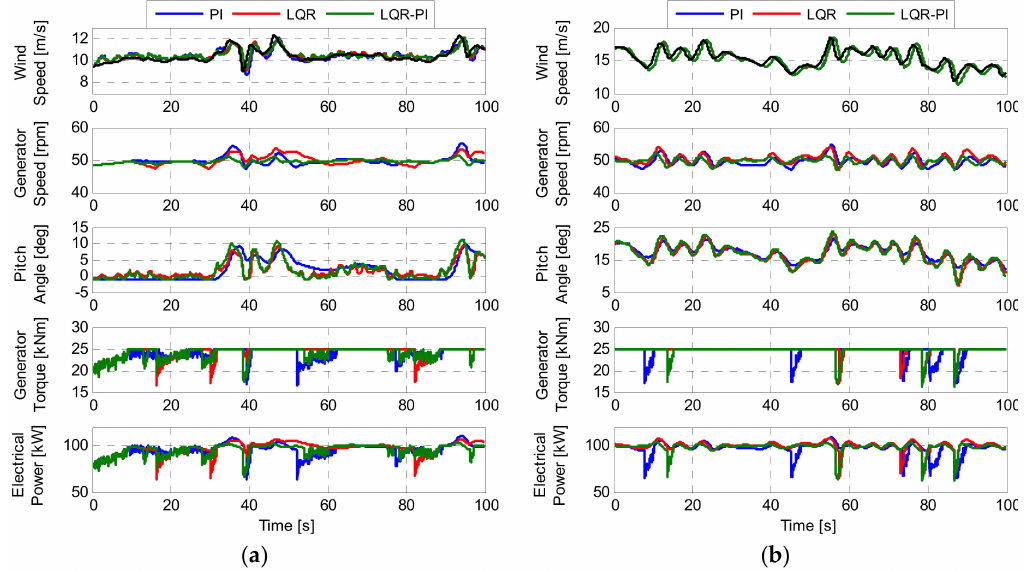
Figure 15. Simulation results according to the control method applied in the presence of noise. ( a ) Transition region; ( b ) rated power